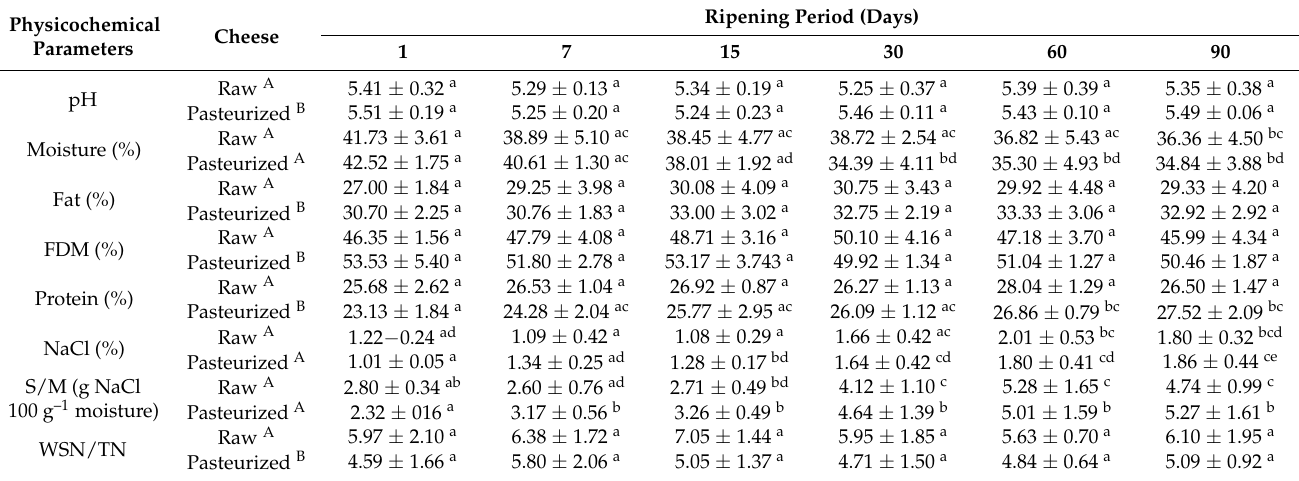
Table 2. Physicochemical characteristics of cheese, during